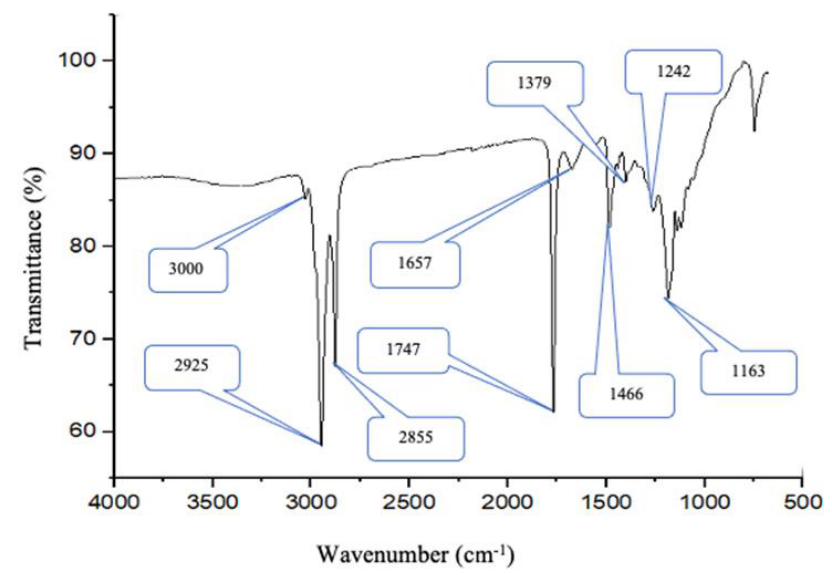
Figure 1. FTIR spectra of bio-coagulant deshelled Carica papaya seeds.